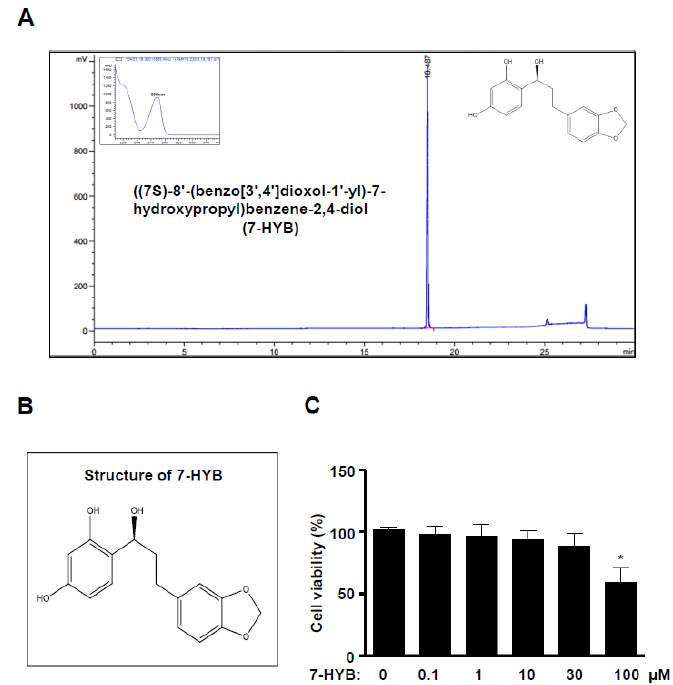
Figure 1. Effect of 7-HYB on the cytotoxicity of preosteoblasts. ( A ) HPLC chromatogram of ((7S)-8′-(benzo[3′,4′]dioxol-1′-yl)-7-hydroxypropyl)benzene-2,4-diol (7-HYB) isolated from the seeds of M. fragrans . ( B ) Chemical structure of 7-HYB. ( C ) Preosteoblasts were cultured in 0.1, 1, 10, 30, and 100 μM of 7-HYB for 24 h, and cell viability was measured by the MTT assay. Data represent the mean ± S.E.M. of experiments. *, p < 0.05: statistically significant difference when compared to the control.